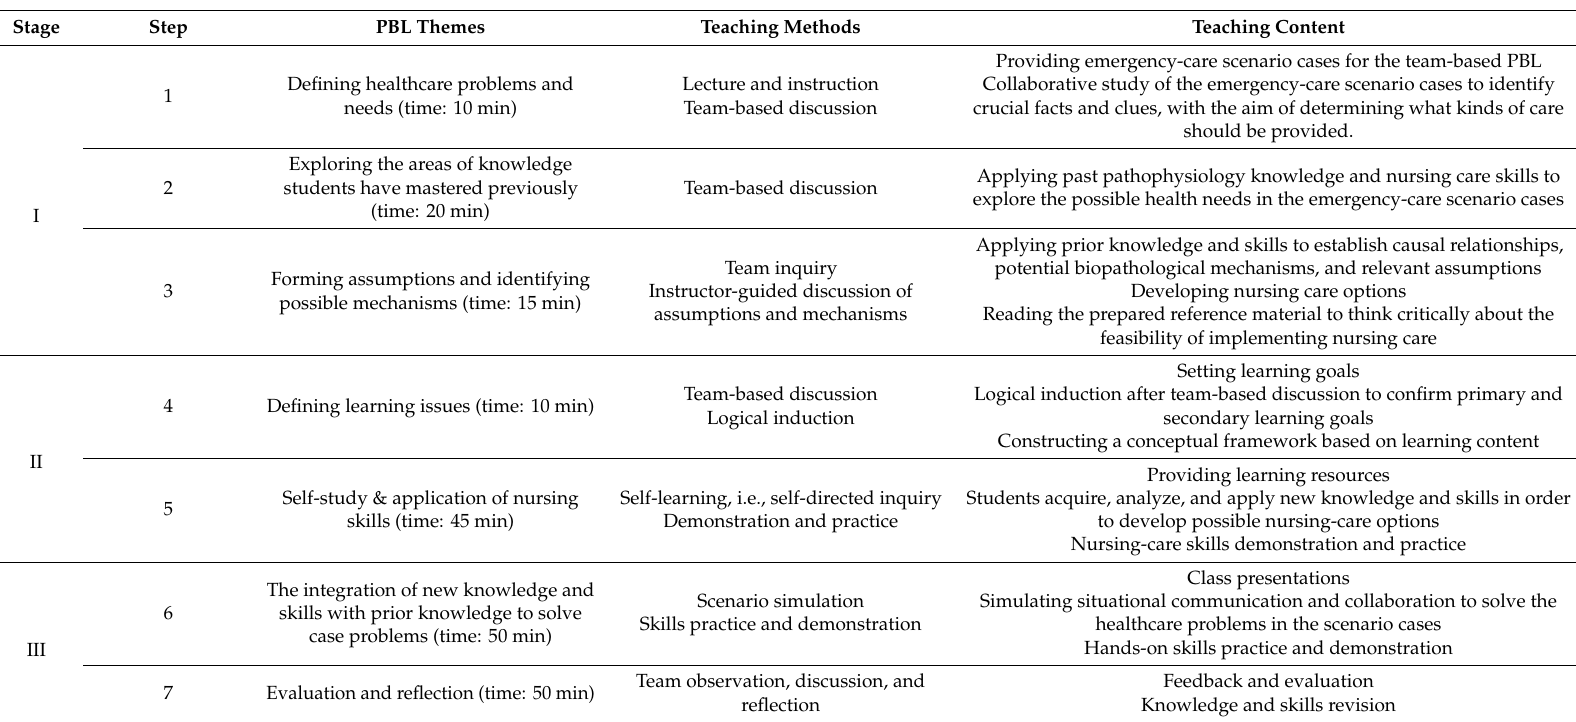
Table 2. Teaching procedure used for the integrative